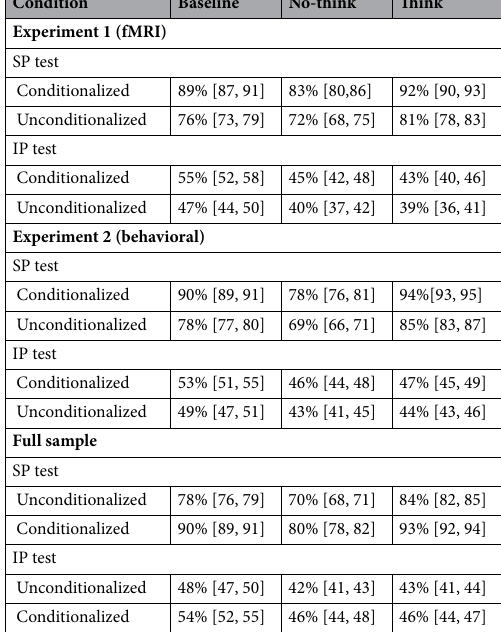
Table 1. Final recall accuracy on the Same-Probe (SP) and the Independent-Probe (IP) tests. Values in brackets reflect the 95% confidence interval for the marginal